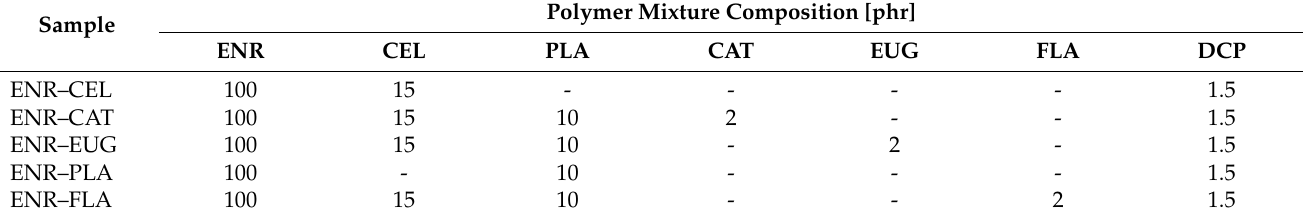
Table 4. Composition of the polymer blend mixtures prepared for analysis in this research. Abbre- viations: ENR — epoxidized natural rubber, PLA — poly(lactic acid), CEL — cellulose, CAT — catechin